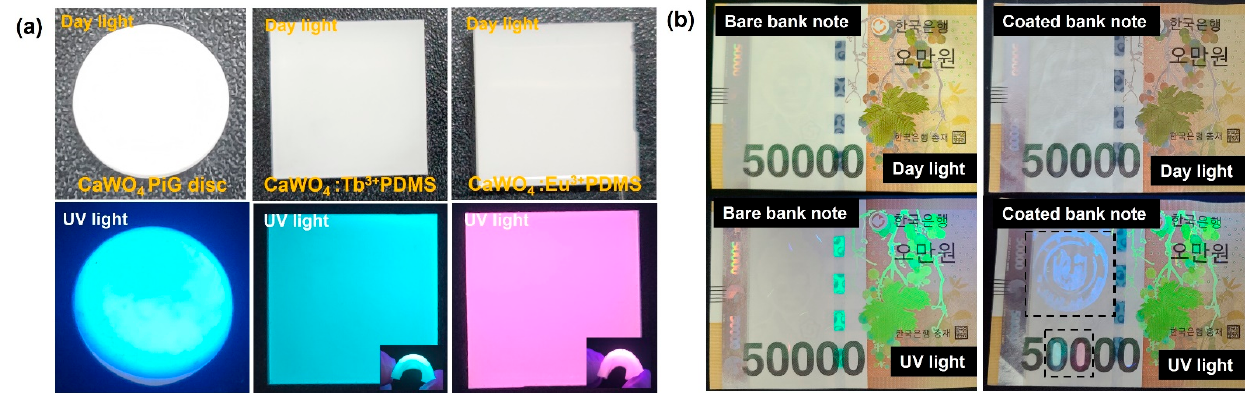
Figure 6. Photograph of ( a ) phosphors in glass disc and flexible composite, ( b ) phosphors painted on bank notes for anti-counterfeiting.